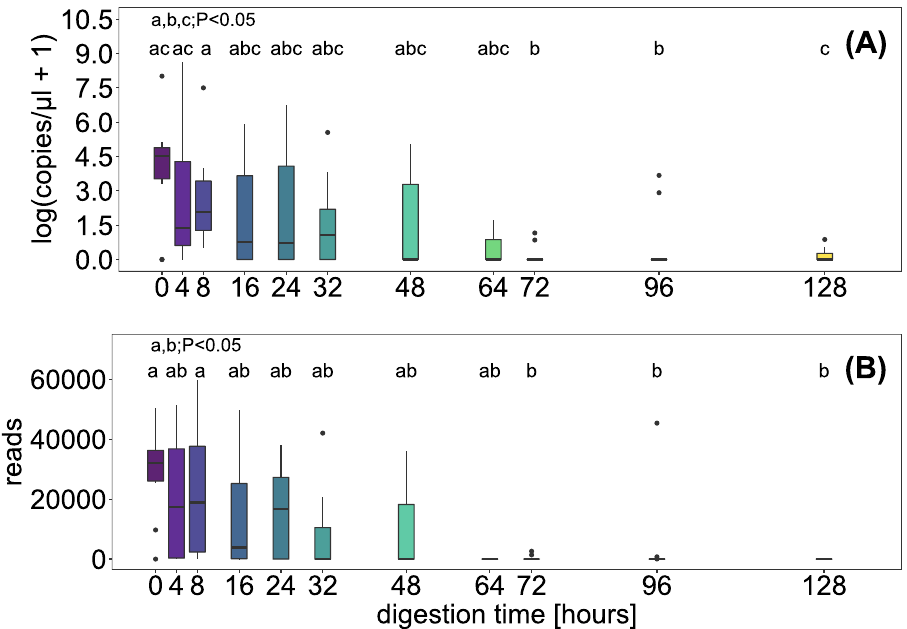
Figure 1. Target copies/µl DNA extract measured with droplet digital PCR ( A , n = 111) and read numbers obtained in HTS ( B , n = 102) of the plant-specific trn L c-h target fragment in regurgitates of Pseudoophonus rufipes , collected at 0, 4, 8, 16, 24, 32, 48, 64, 72, 96 and 128 h after feeding on three seeds of Taraxacum officinale. Boxplots of measured values, letters indicate time groups that were significantly different in pairwise Wilcoxon tests with BH correction for multiple